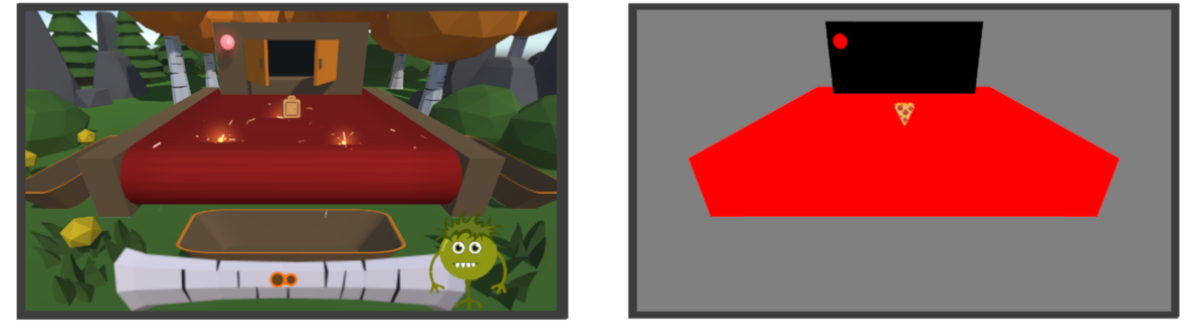
Figure 2. Left: Stop trials in the gamified version. After the stop-signal delay, the light at the warehouse gate and the conveyor belt turned red. Furthermore, the conveyor belt emitted sparks, resembling a short circuit. Right: Stop trials in the nongamified version. The area covered in red matches the location but is slightly larger than in the gamified version. Participants were requested to wait without responding until the end of the trial.